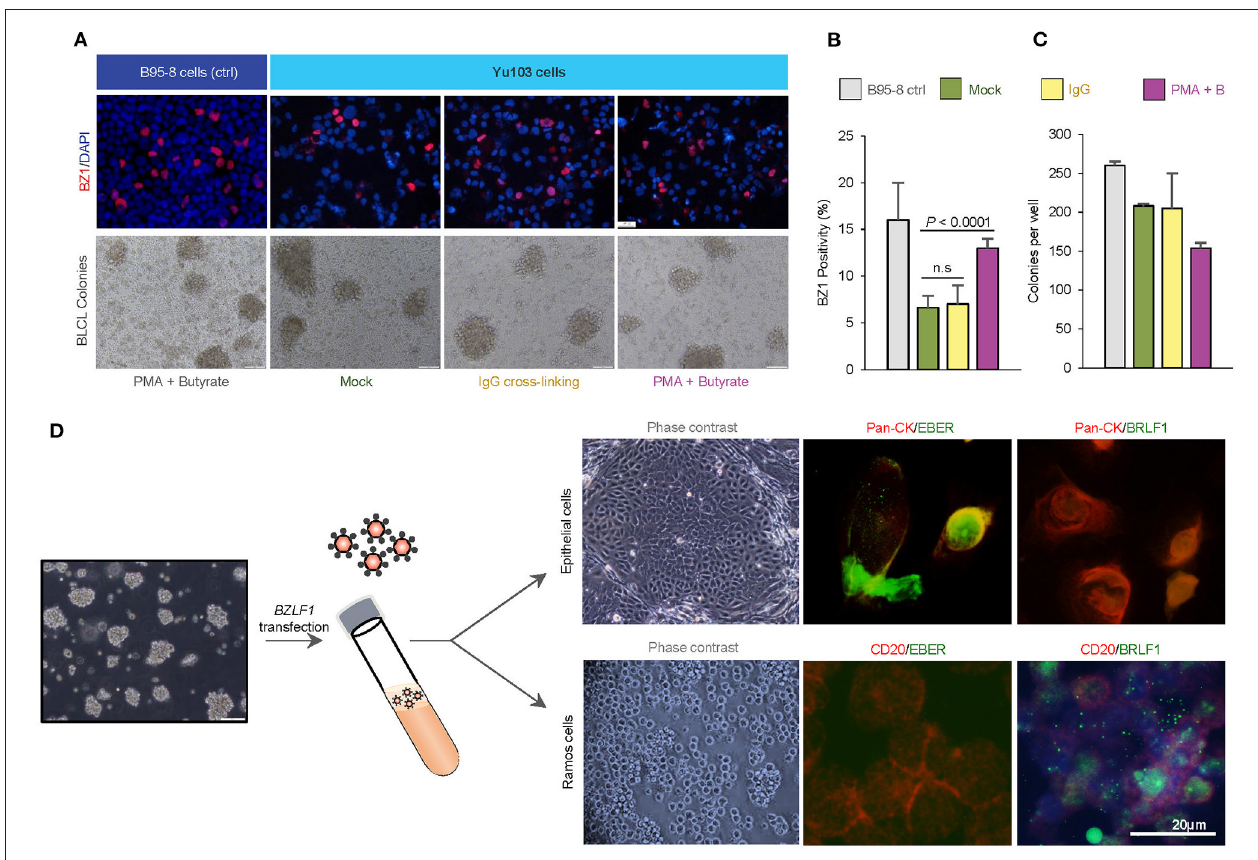
FIGURE 4 | Tractability and cellular tropism of Yu103 EBV cells. (A–C) The amenability of Yu103 EBV to common chemical [a combination of phorbol 12-myristate 13-acetate (PMA) and sodium butyrate] and biological [immunoglobulin (IgG) cross-linking of B-cell receptors] induction methods were tested. We quantified complexes formed between monoclonal BZ1 and the viral immediate-early protein ZEBRA (encoded by BZLF1), a sensitive and early marker for entry into the lytic phase, and the EBV + marmoset cell line B95-8 was used as a positive control. (D) Despite originating from nasopharyngeal carcinoma, Yu103 EBV were found to have comparable infective and transforming powers as B95-8 EBV, while retaining epitheliotropic abilities. Shown are representative panels of dual EBER-ISH (green) and immunocytochemistry of pan-CK (epithelial cells in red) or CD45 (lymphocytes in red) in cell cytospin slides. All statistical analyses were conducted according to